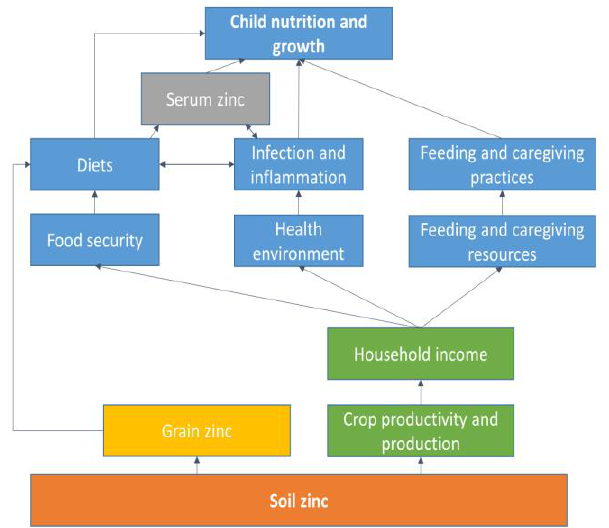
Figure 1. A conceptual framework describing the relationships among soil zinc, serum zinc status and linear growth of children (based on a framework to achieve optimum child nutrition and development from Black et al [26]).